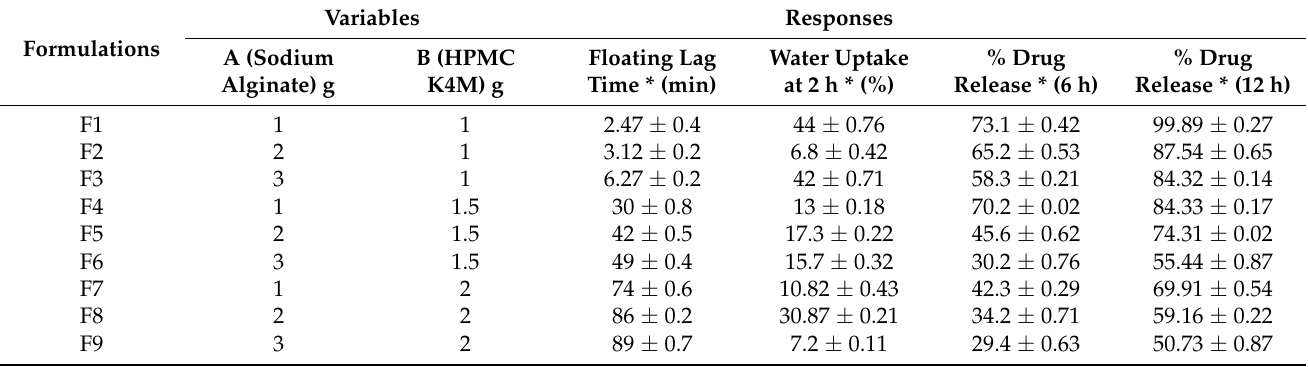
Table 6. Observed responses in 3 2 full factorial design for the oral raft-forming in situ gelling system of NTB.